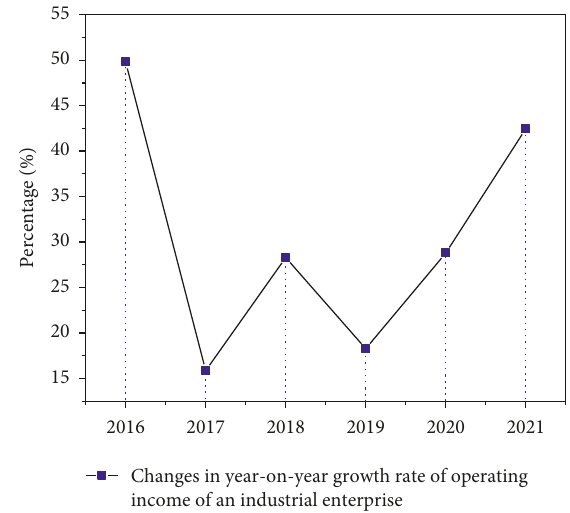
Figure 7: Change of year-on-year growth rate of operating income of an industrial